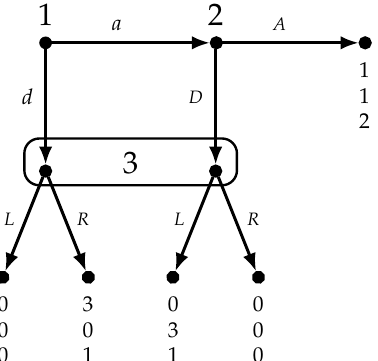
Figure 3. The play aA is consistent with the notion of self-confirming equilibrium, even though there is no Nash equilibrium that yields aA